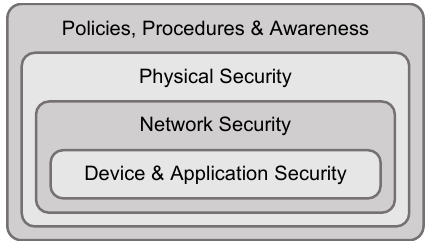
Figure 2. Following the principle of defense-in-depth, providing security for interconnected power grids needs to encompass a comprehensive set of measures for (i) device and application security, (ii) network security, (iii) physical security, as well as (iv) policies, procedures, and